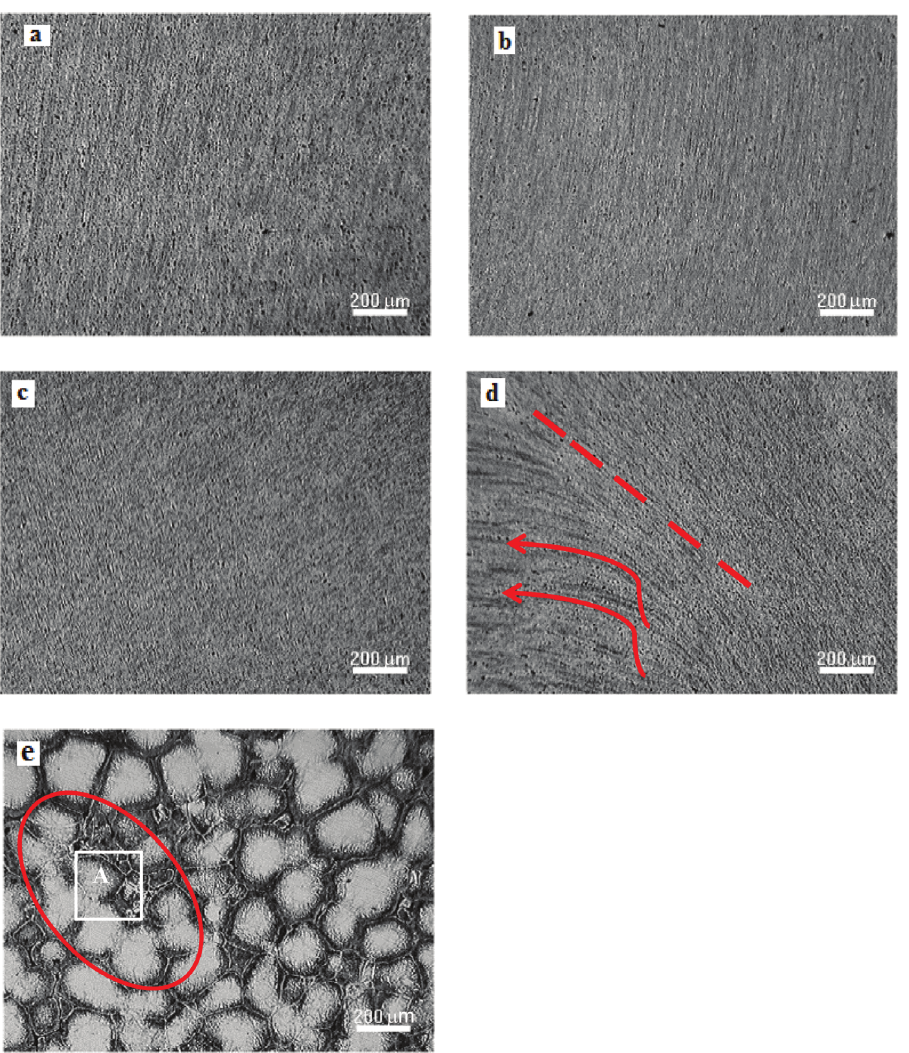
Figure 1: Optical micrograph of AA7075: ECAP one passed (a), ECAP two passed (b), ECAP three passed (c), ECAP four passed (d) and casting